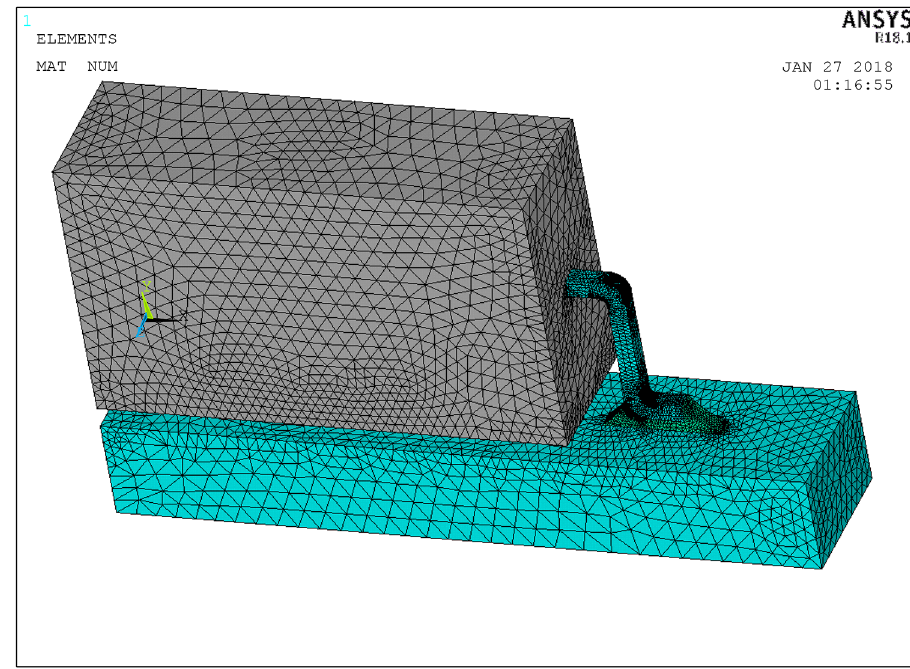
Fig. 5. Local model of the solder joints.